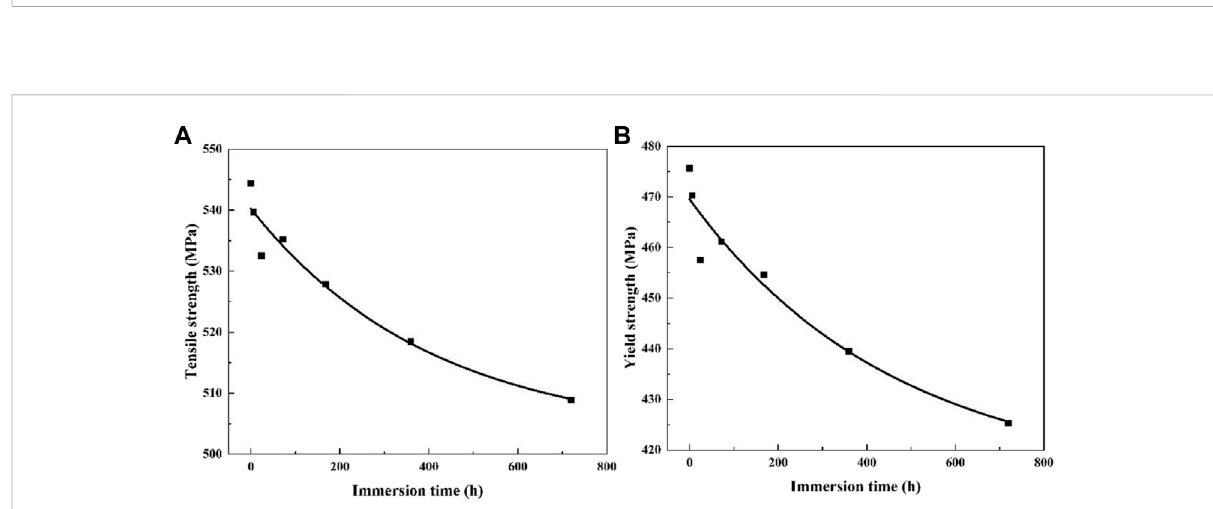
FIGURE 9 The trend of mechanical properties of 2060-T6 Al-Li alloy with immersion time and its fi tting curve, (A) tensile strength, (B) yield strength.